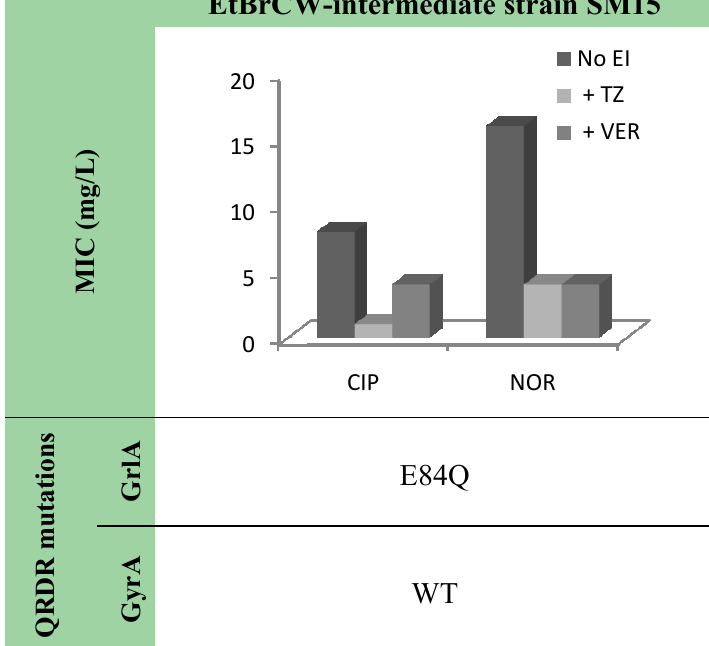
Figure 3. Effect of the efflux inhibitors thioridazine (TZ) and verapamil (VER), at a subinhibitory concentration (12.5 mg/L and 200 mg/L, respectively), on the MIC values of ciprofloxacin and norfloxacin for the EtBrCW-intermediate strain SM15. WT: wild-type sequence (no